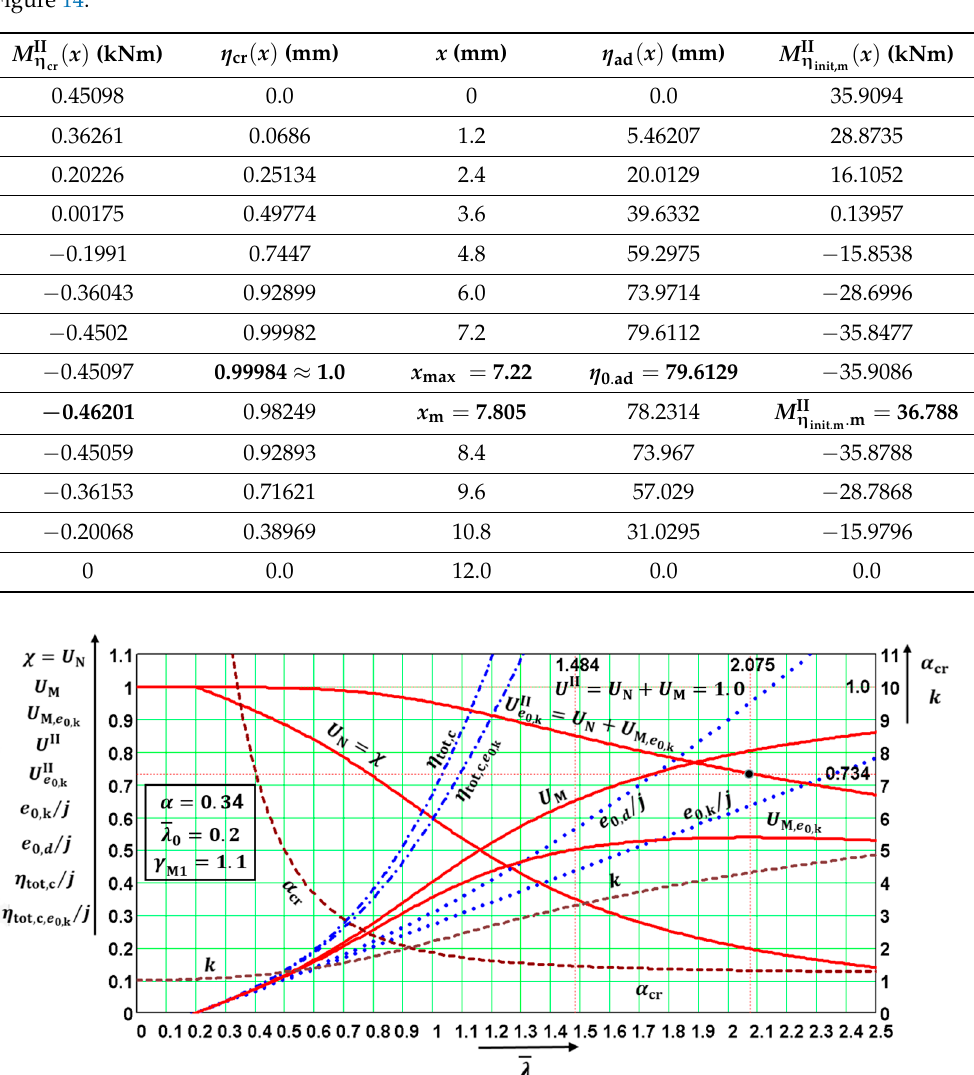
Figure 13. Geometrical interpretations of quantities η tot,c / j , U N , U M and U , which are functions of three parameters: α , λ , and λ 0 and quantities α cr , k , U M, e depend on four parameters: α , λ , λ 0 , and safety factor γ M1 .